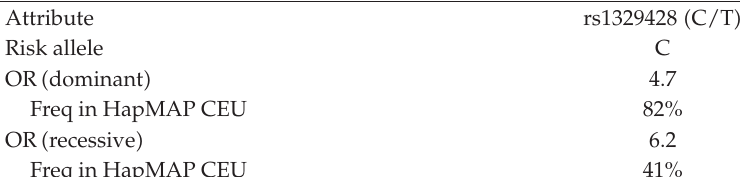
Table 1: An SNP from Klein et al. (cid:3) 1 (cid:4) .